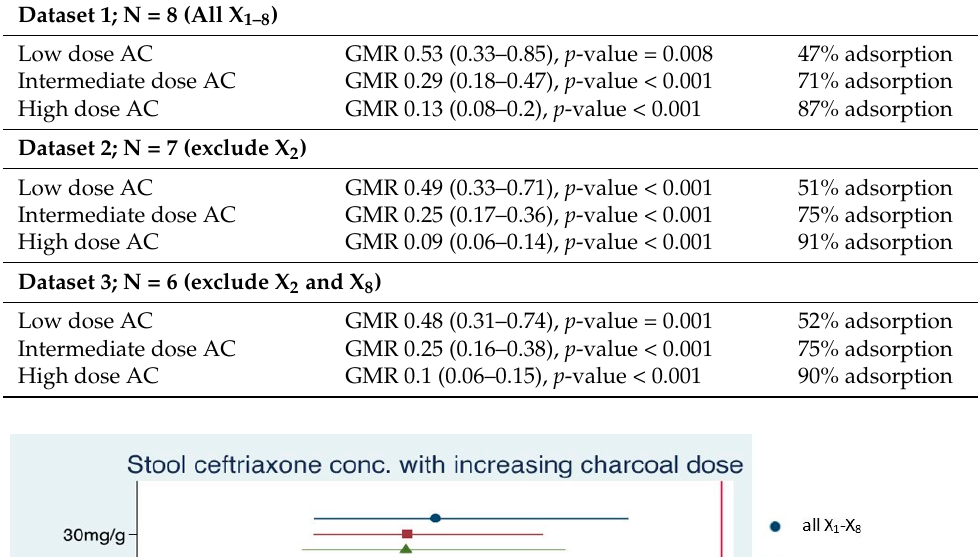
Figure 3. The association of fecal ceftriaxone levels (mcg/mL) and post-IV-ceftriaxone duration prior to fecal sample collection (hours). Table 3. Geometric mean reduction (GMR), 95%CI and p -value, and % adsorption by activated charcoal (AC) at low dose 30 mg/g feces, intermediate dose 150 mg/g feces, and high dose 500 mg/g feces.